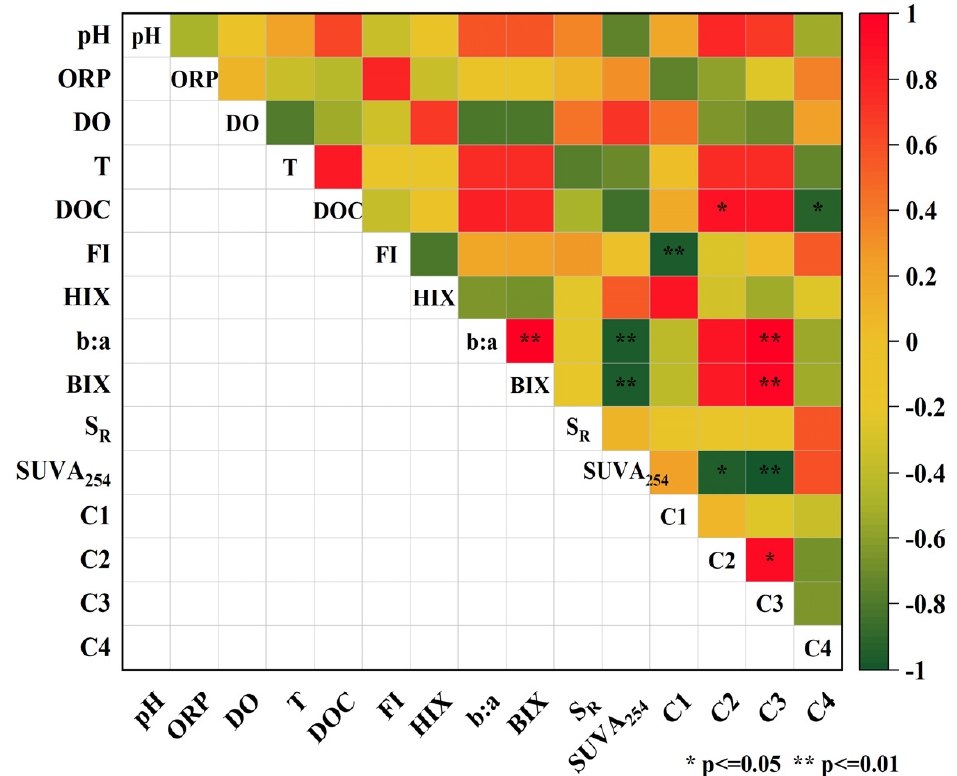
Figure 8. Correlation between the DOM and environmental parameters .